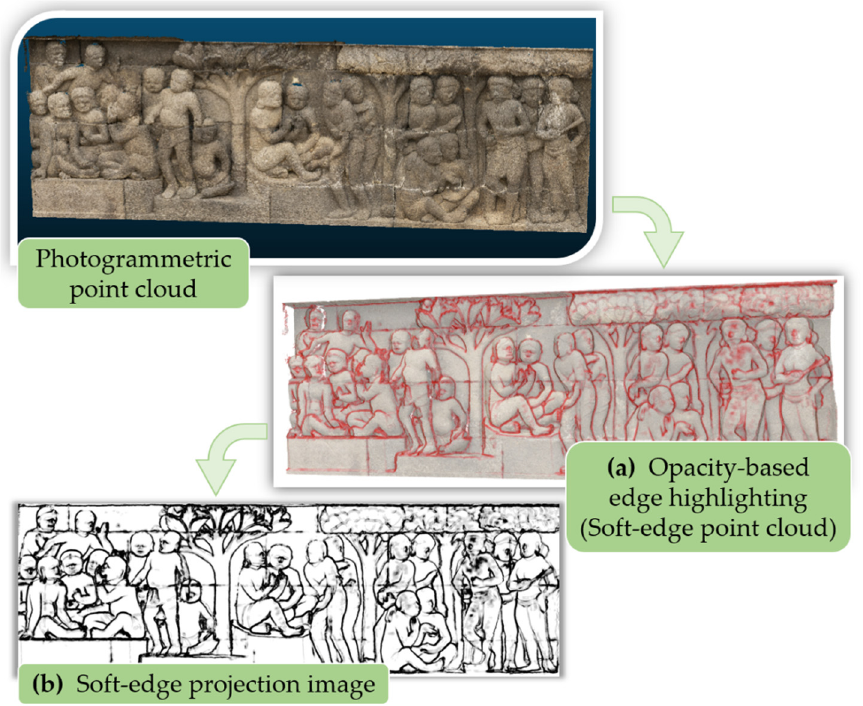
Figure 5. Soft-edge extraction from relief photogrammetric point cloud by opacity-based edge highlighting and image projection.